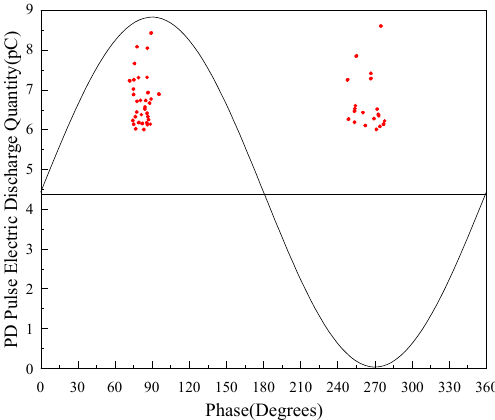
Figure 20. Discharge pattern of the filth defects inside GIS under 12.5 kV.